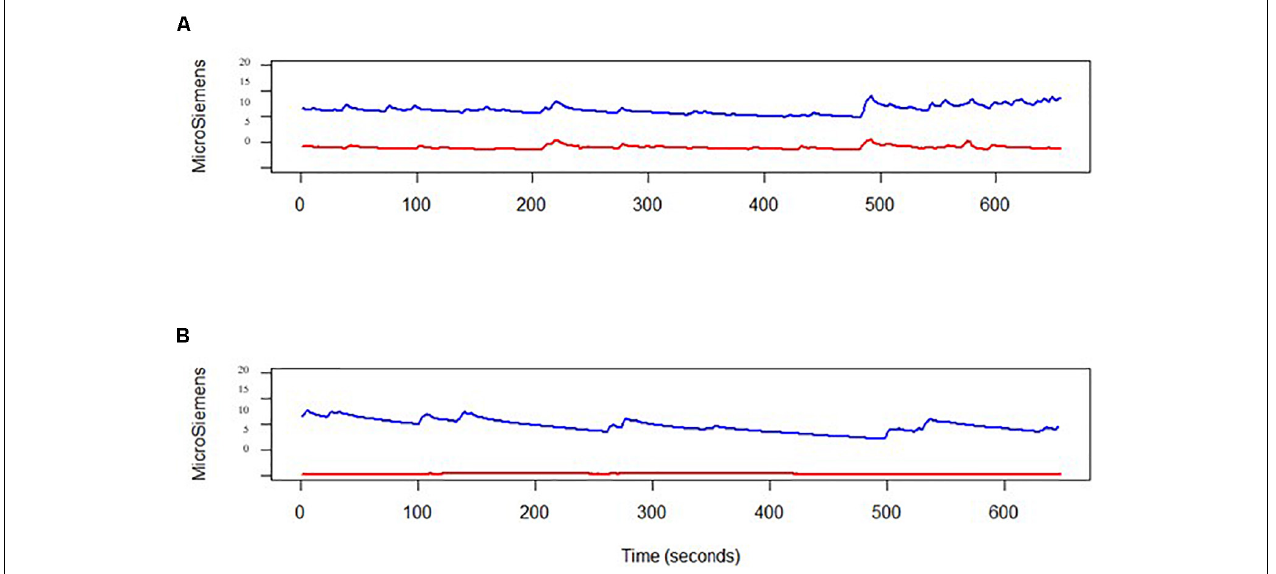
FIGURE 2 | Two examples of two skin conductance level time-series obtained by both the E4 (in red) and by the MW mobile device (in blue). (A) Medium–high correlation ( r = 0.538); (B) non-reliable E4 data collection, that was dropped from the analysis.